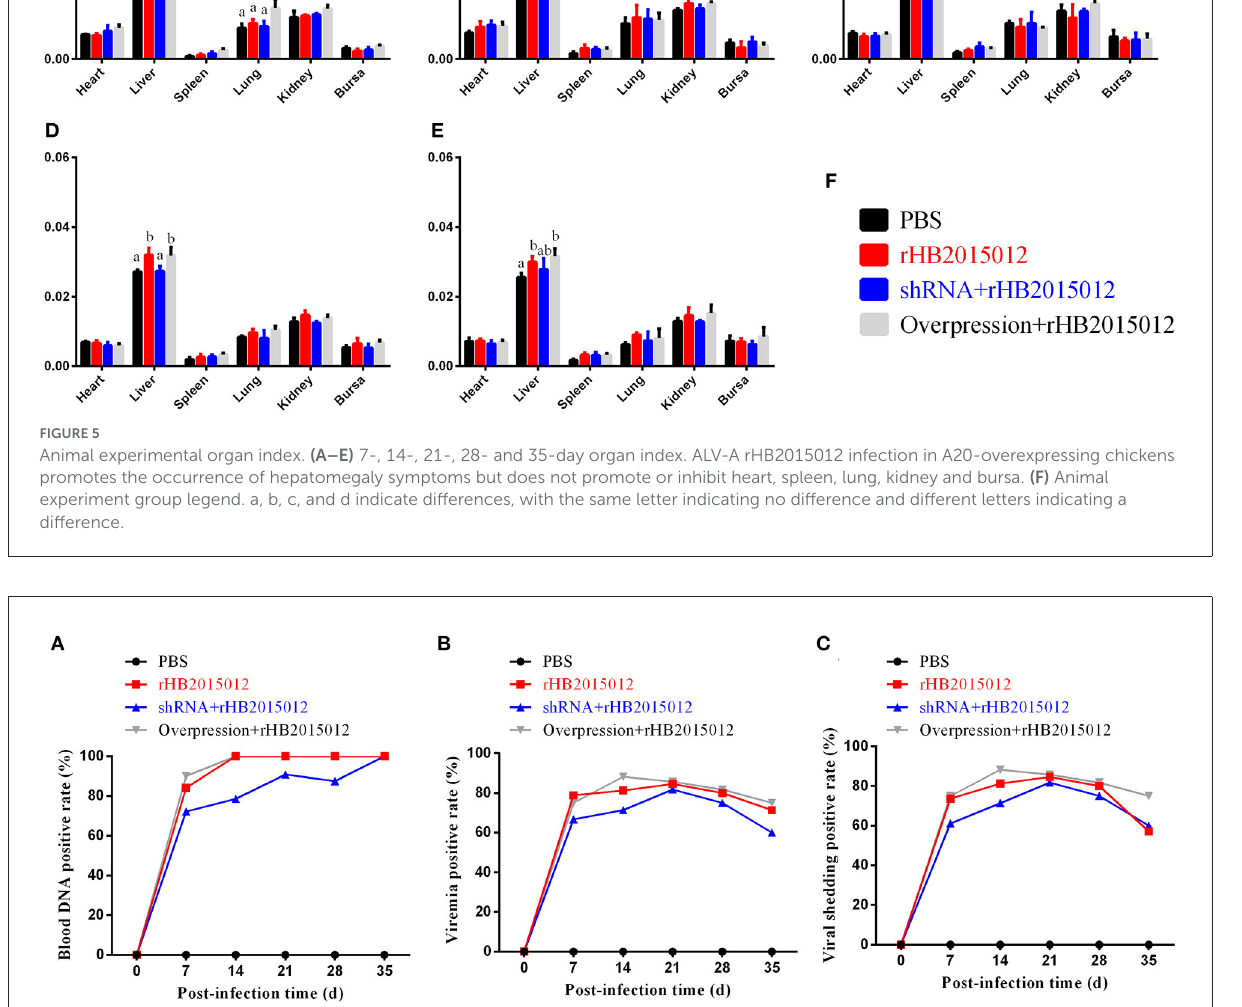
time points, and the results are demonstrated in Figure 4. At 35 days of ALV-A infection, the average net weight gains of the negative, positive, shRNA, and overexpression groups were 293.4, 216.9, 263.0 and 195.7 g, respectively. These data suggest that A20 could regulate chicken growth after ALV-A